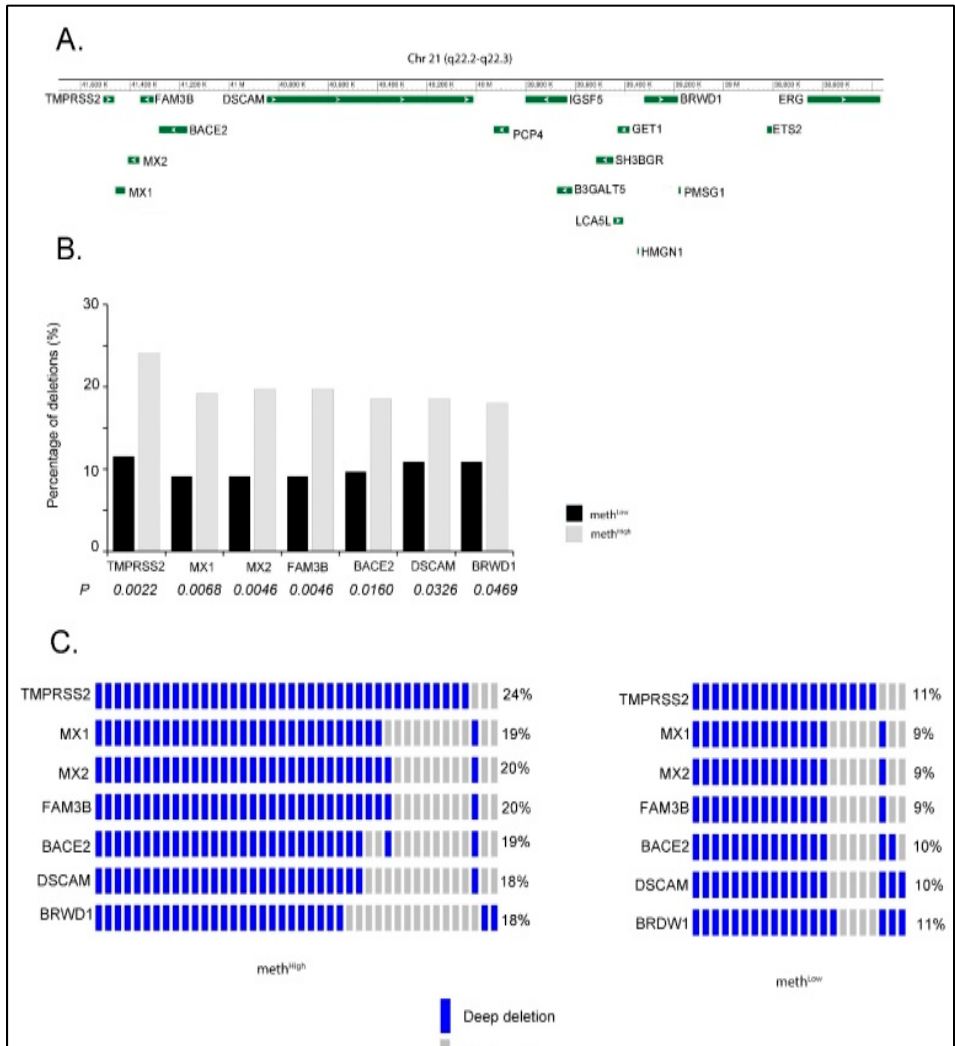
Figure 4. USP44 promoter methylation and its correlation to deletions in the genomic region be- tween TMPRSS2 and ERG genes in prostate adenocarcinoma patients. ( A ) Genome view of the chromosomal region Chr 21 (q22.2-q22.3). ( B ) Copy number variation data for Chr 21 (q22.2-q22.3) for meth High and meth Low groups. CNV data were obtained by TCGA-PRAD (Firehose Legacy). p values underneath the gene names were calculated with Mann-Whitney test. ( C ) Oncoprints indicating patients with gene deletion events within the chromosomal region Chr 21 (q22.2-q22.3) in meth High (left) and meth Low (right) group. Gene deletion frequencies (%) within each group are indicated on the right side of the oncoprint. Oncoprints were generated through cbioportal using CNV data from TCGA-PRAD (Firehose Legacy) (**** indicates p<0.0001 ).